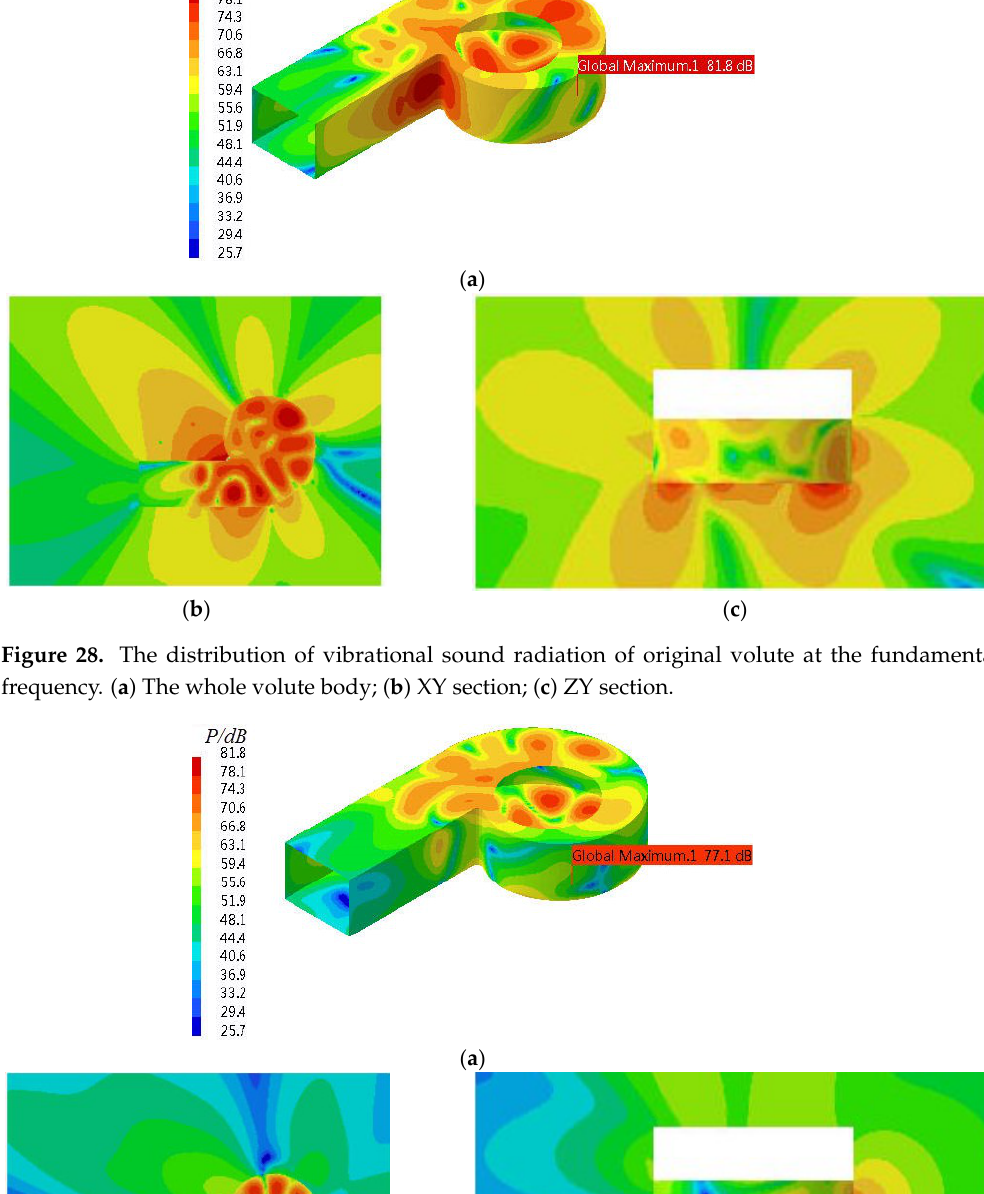
Figure 27. The radiated sound power spectrum of the volute structural surface.